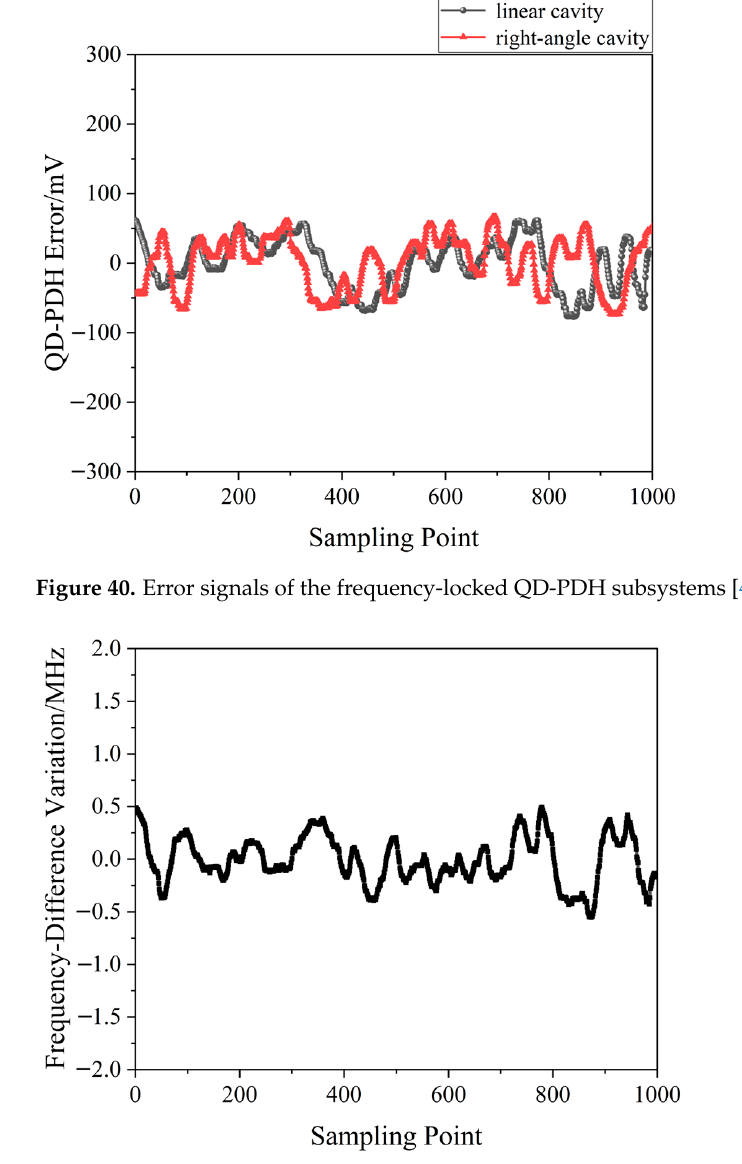
Figure 41. Frequency difference variation in the frequency-locked dual-frequency Nd:YAG laser [43] .